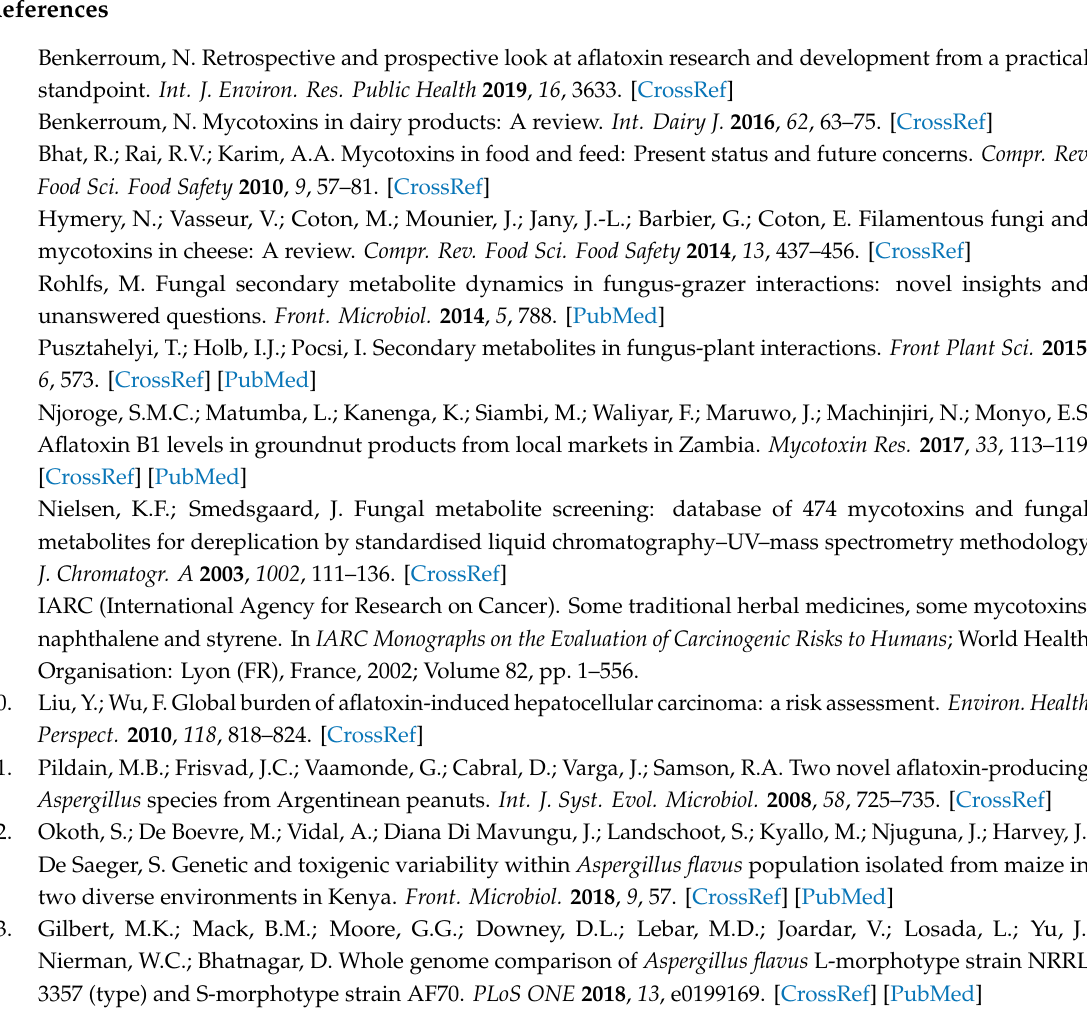
Table S1: Key properties of aflatoxins and their metabolites. Data compiled from PubChem of the National Center for Biotechnology Information (https: // pubchem.ncbi.nlm.nih.gov) and ChemSpider of the Royal Society of Chemistry (http: // www.chemspider.com) databases, unless references are indicated beside the data, Table S2: Incidence (%) and concentrations ( µ g / kg) of aflatoxins in staple agricultural products of selected countries from Sub-Saharan Africa. Data are for total aflatoxins (B1 + B2 + G1 + G2), unless otherwise stated in the footnotes, Table S3: Incidence and concentrations ( µ g / kg) of aflatoxin contamination of staple crops in selected countries from the Southeast Asian region. Data are for total aflatoxins (B1 + B2 + G1 + G2), unless otherwise stated in the footnotes. Funding: This research received no external funding. Conflicts of Interest: The author declares no conflict of